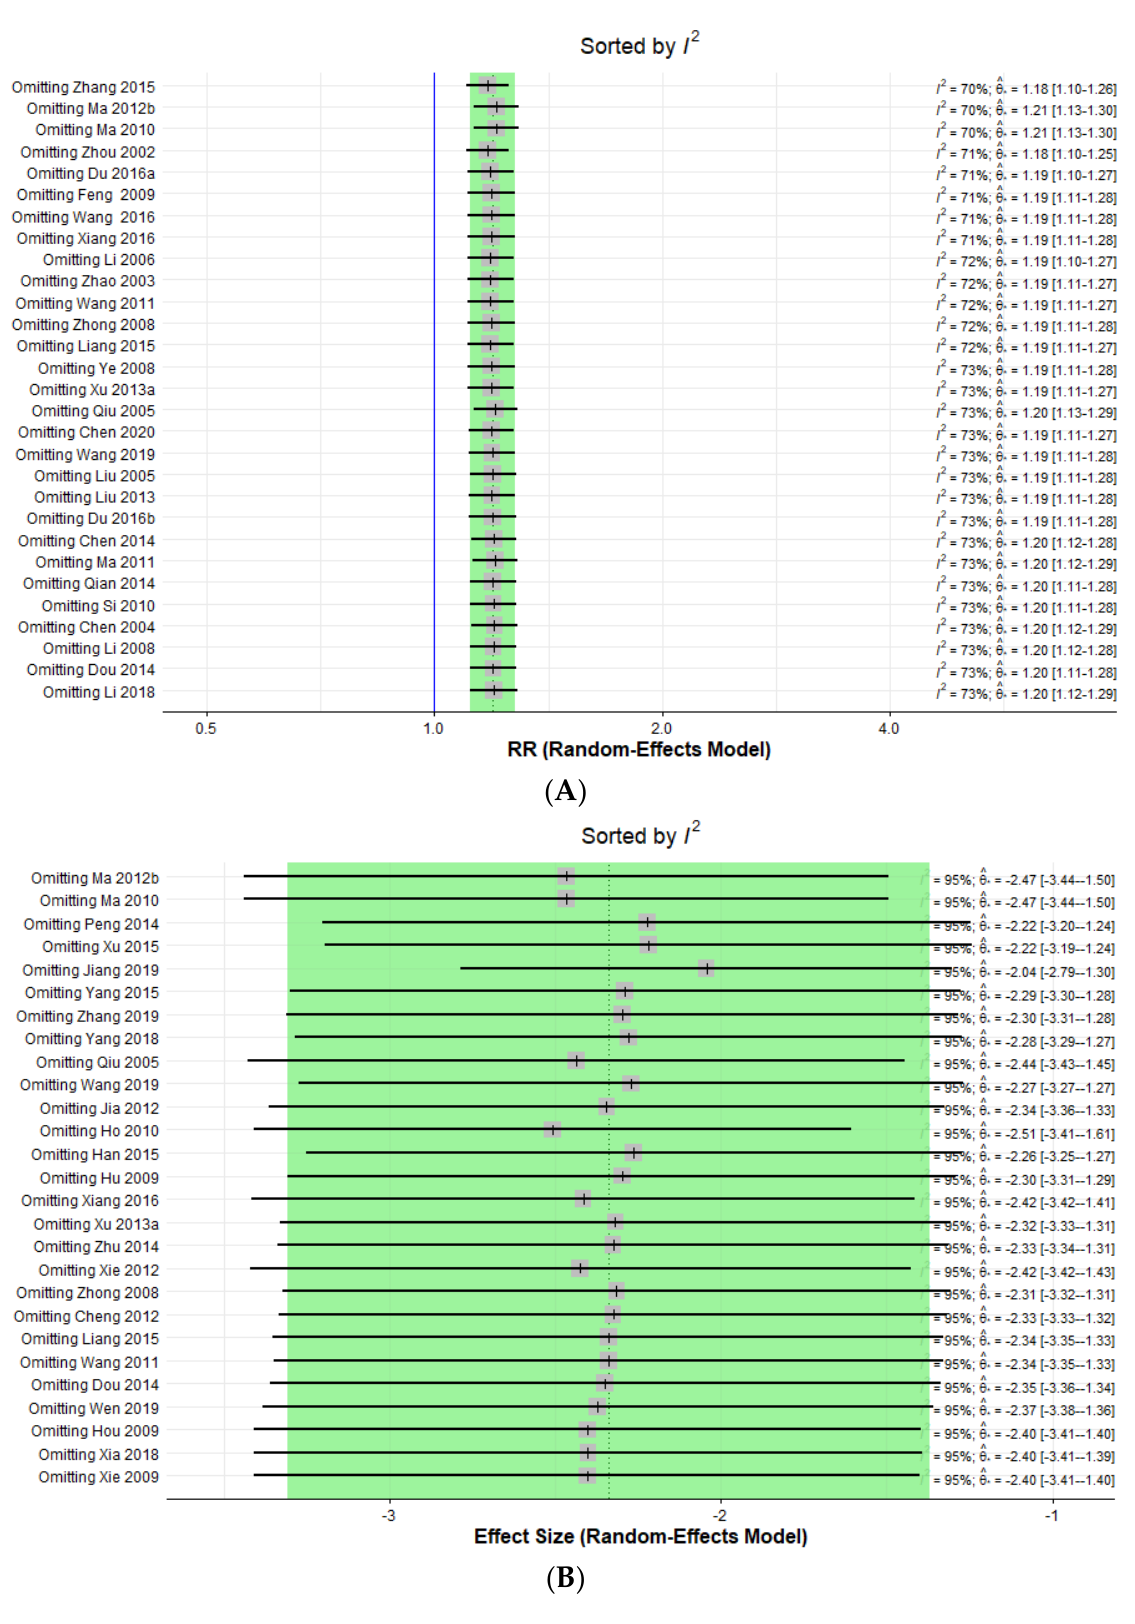
Figure 7. ( A ) Forest plot of the sensitivity analysis ordered by heterogeneity for PASI 60, ( B ) forest plot of the sensitivity analysis ordered by heterogeneity for continuous PASI score.